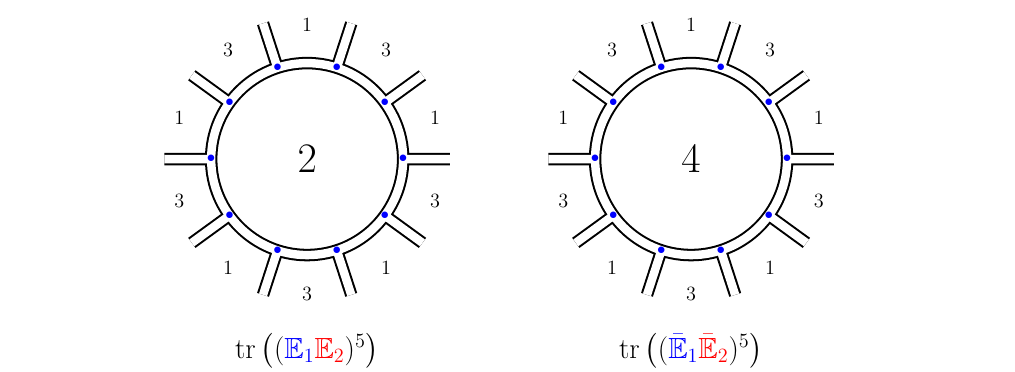
Figure 21 . Splitting non-BPS vertices.